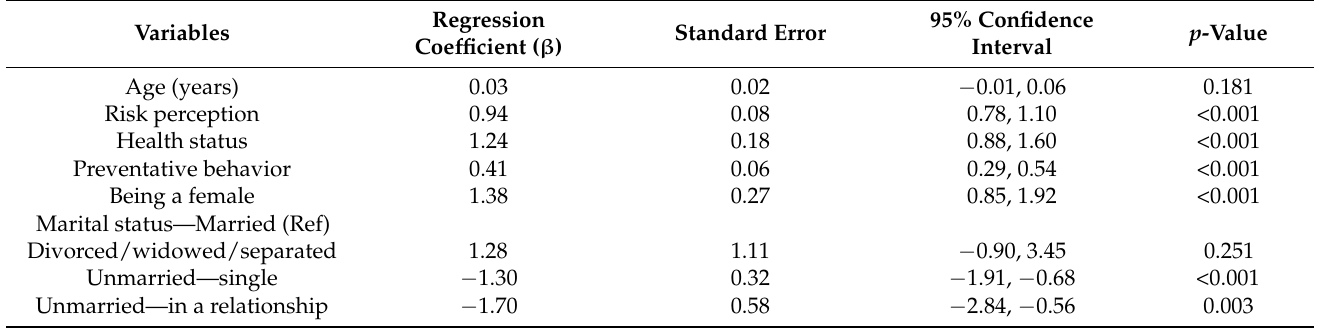
Table 4. Results of multiple regression on factors associated with the fear of COVID-19 (N =